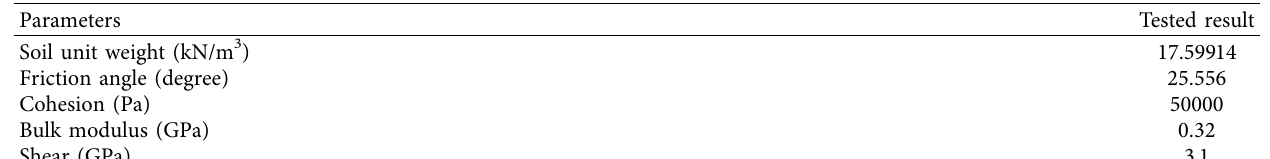
Table 1: Waste dump material properties extracted from laboratory tests.